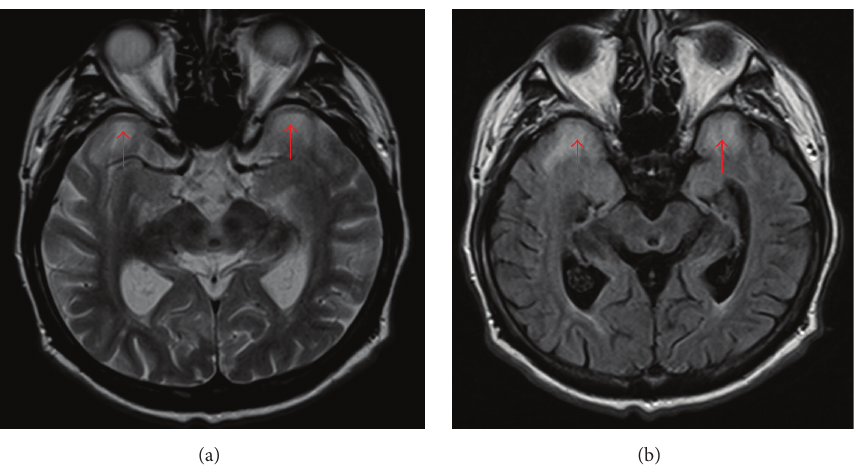
Figure 4: Brain MRI. Anterior temporal lobe hyperintensities on T2-weighted (a) and FLAIR (b)